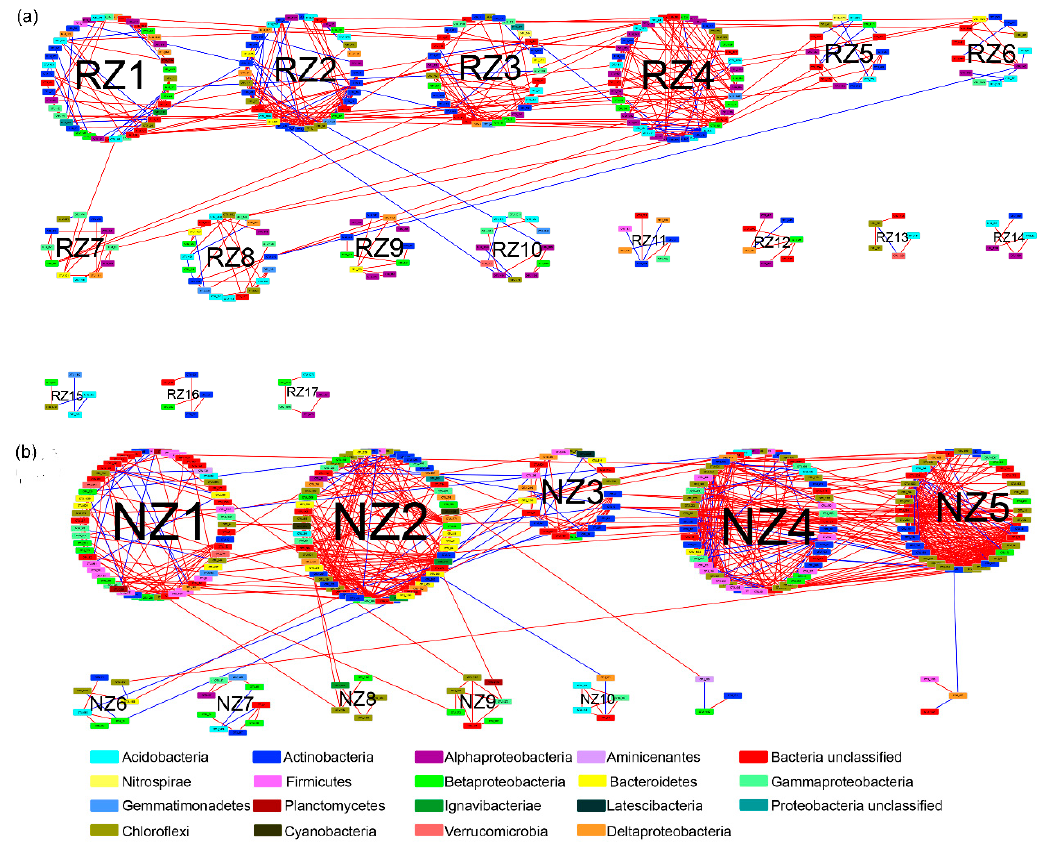
Figure 5. An overview of bacterial networks in P. australis zone ( a ) and non- P. australis zone ( b ). Node color represents bacterial phylum of the OUT. Red edges indicate positive relationships and blue edges indicate negative relationships. Modules lager than five nodes are labeled with a number. Table 2. Topological properties of bacterial networks under RZ ( P. australis zone) and NZ (non- P. australis zone), and their corresponding random